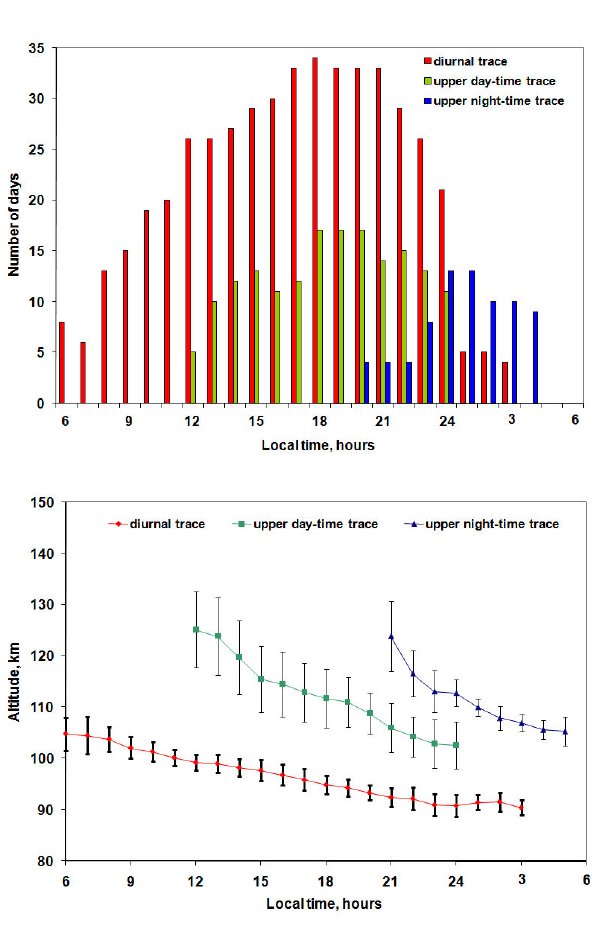
Fig. 4. Statistics of the averaged E s traces as a function of altitude and local time, during a 24-h day starting at 06:00LT, shown here for winter (December, January, and February). The upper panel presents the occurrence distributions of the three dominant traces shown separately in the lower panel. The error bars represent the mean error. The colors between the two panels are in correspon- dence.